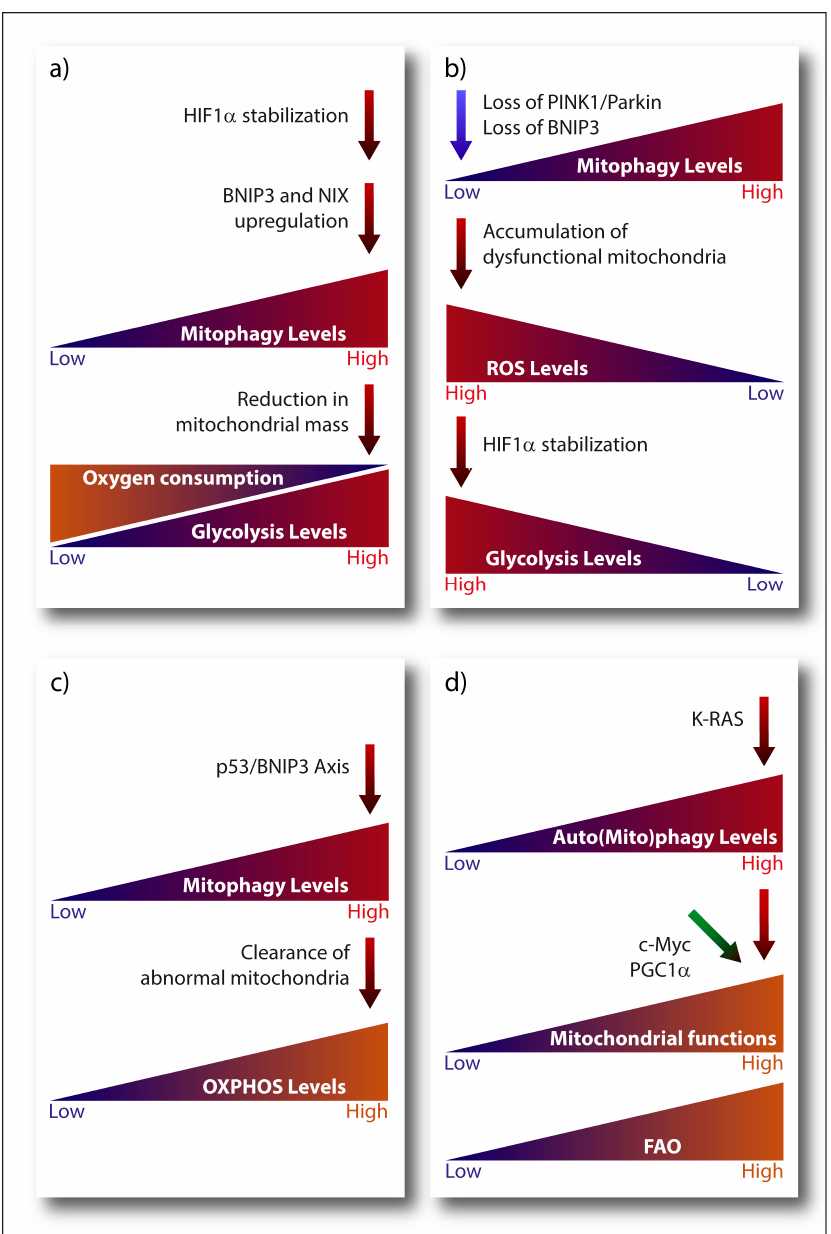
Figure 2. Emerging links connecting oncogene-driven metabolic pathways and key modulators of the mitophagic machinery. ( a ) Upregulation of BNIP3 and NIX expression induced by HIF-1 α diminishes mitochondrial mass and O 2 consumption. ( b ) Loss of BNIP3 or PINK1 / Parkin expression reduces mitophagy, leading to the accumulation of damaged mitochondria and ROS, which promotes HIF-1 α stabilization and subsequently glycolysis. ( c ) p53 and BNIP3-dependent mitophagy removes abnormal mitochondria, reducing glycolysis and promoting O 2 consumption. ( d ) RAS driven tumors require elevated autophagy / mitophagy levels to maintain mitochondrial functions and carry out proficient FAO. PGC1 α and c-Myc are key regulators of mitochondrial functions to provide cancer cells with metabolic